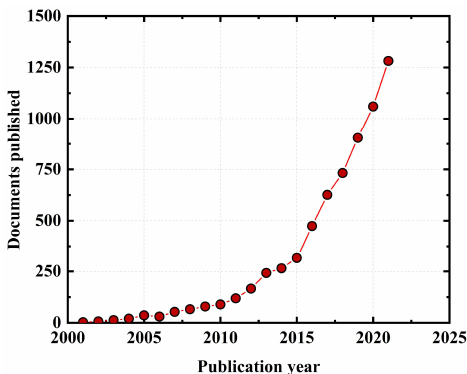
Figure 3. Quantity of papers on fiber-reinforced geopolymer concrete annually published in Science Direct.